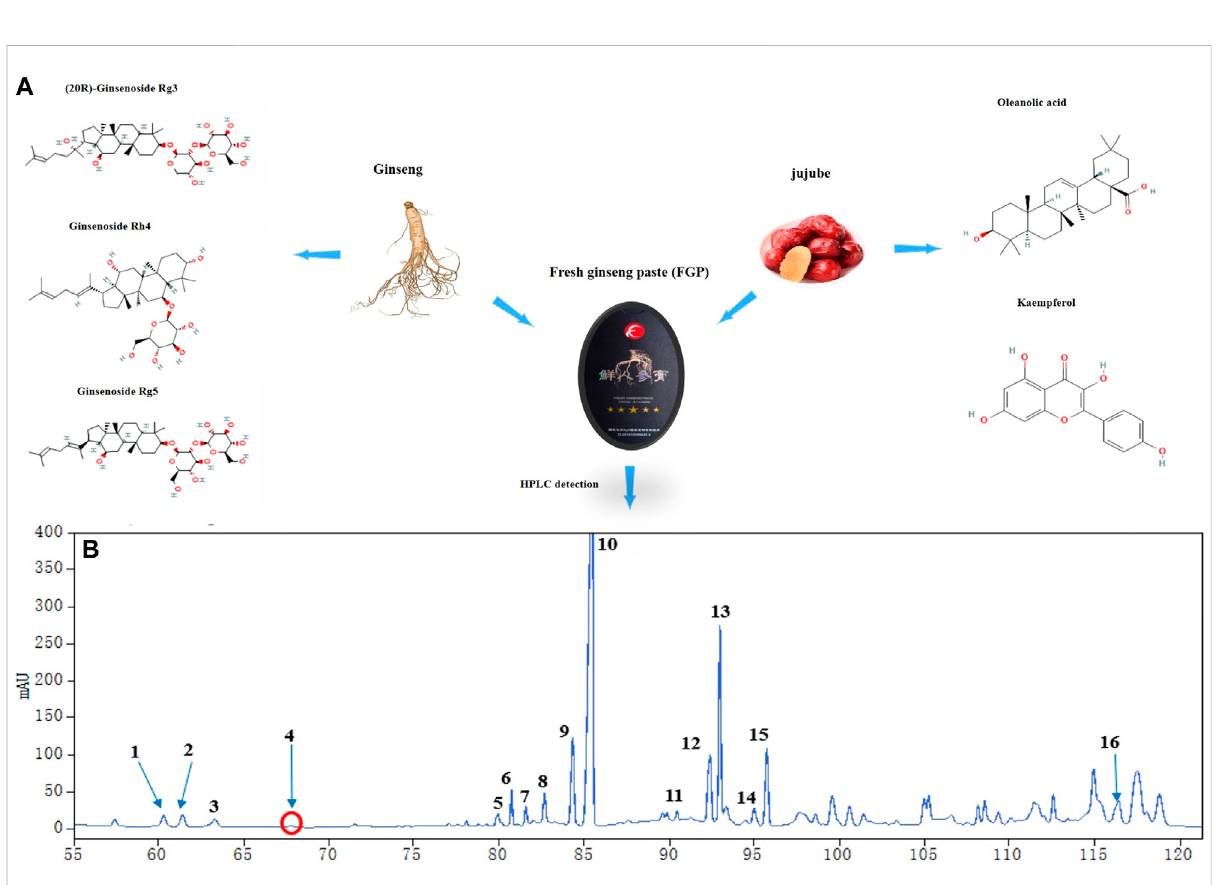
FIGURE 1 Analysis of principal components in FGP. Main components of Fresh ginseng paste (FGP) (A) ; Identi fi cation of the main components in FGP by HPLC analysis (B) ; 1. (S)-Rg2; 2. (S)-Rh1; 3. (R)-Rh1; 4. F1; 5. Rg6; 6. F4; 7. Rk3; 8. Rh4; 9. (S)-Rg3; 10. (R)-Rg3; 11. CK; 12. Rk1; 13. Rg5; 14. (S)-Rh2; 15. (R)-Rh2; 16.